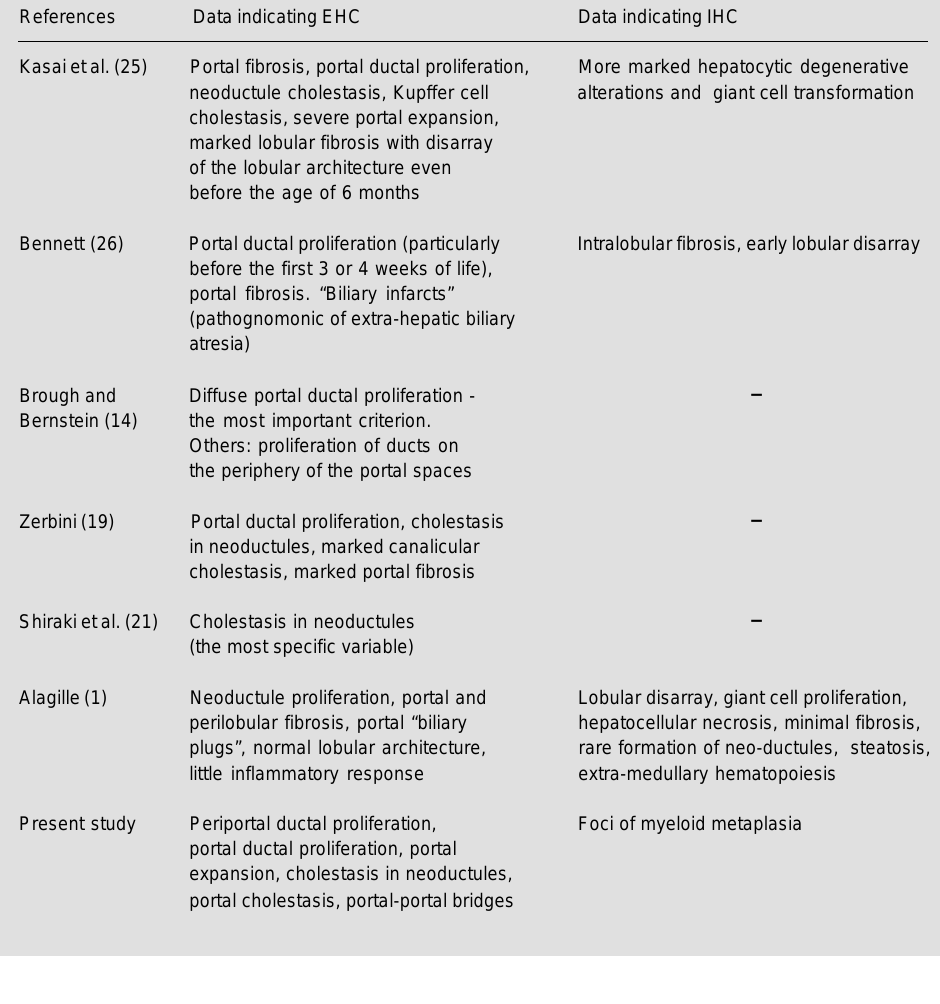
Table 3 - Hepatic histopathological variables which are discriminatory between IHC and